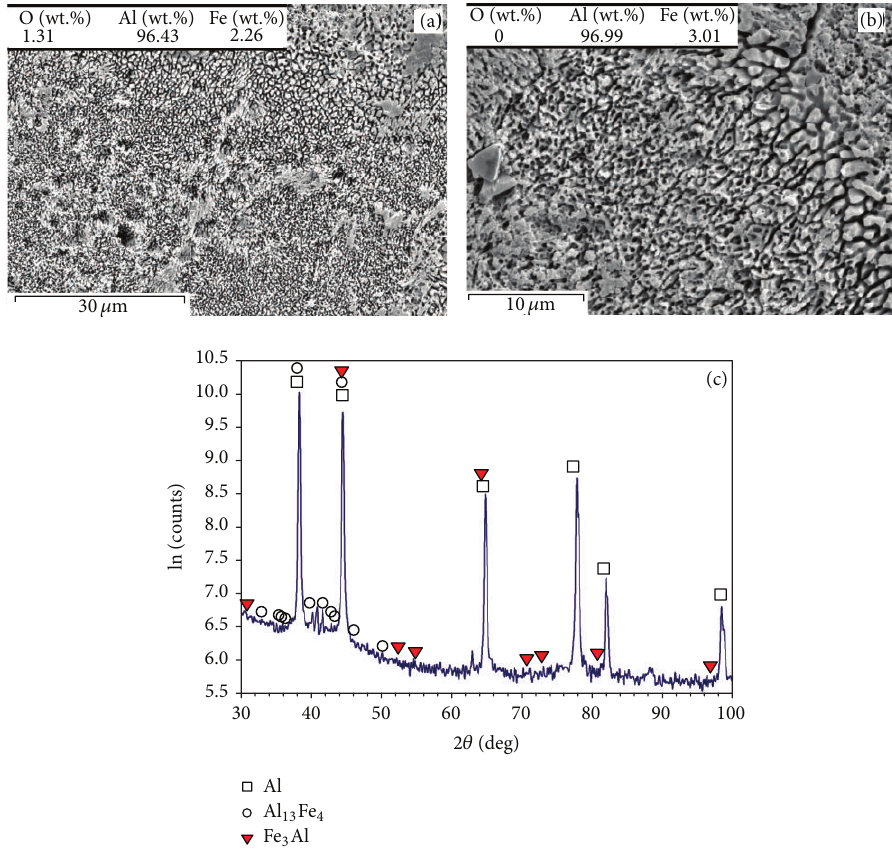
Figure 7: (a) Overall appearance of the grain structure, (b) higher magnification of coralline-like and fuzzy appearance in the previous image, and (c) XRD pattern of the part fabricated when 𝑃 = 82 W, V = 0.5 m/s, and 𝑡 = 75 𝜇 m.